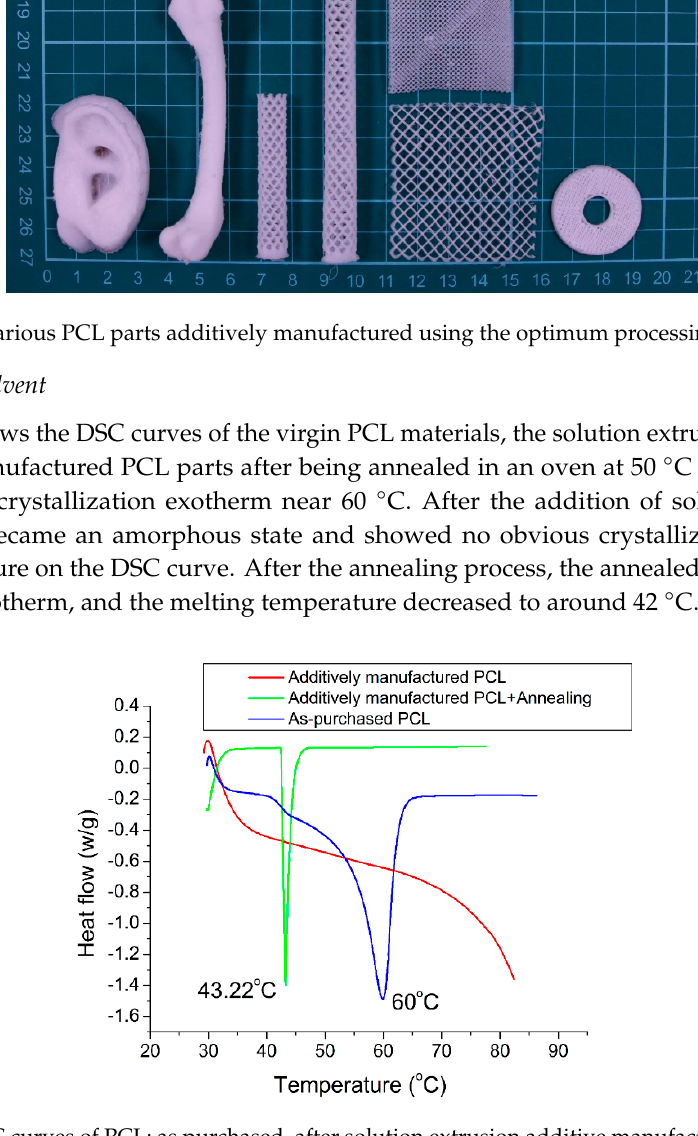
Figure 14. DSC curves of PCL: (a) as purchased, (b) after solution extrusion additive manufacturing, and (c) after solution extrusion manufacturing and annealing.